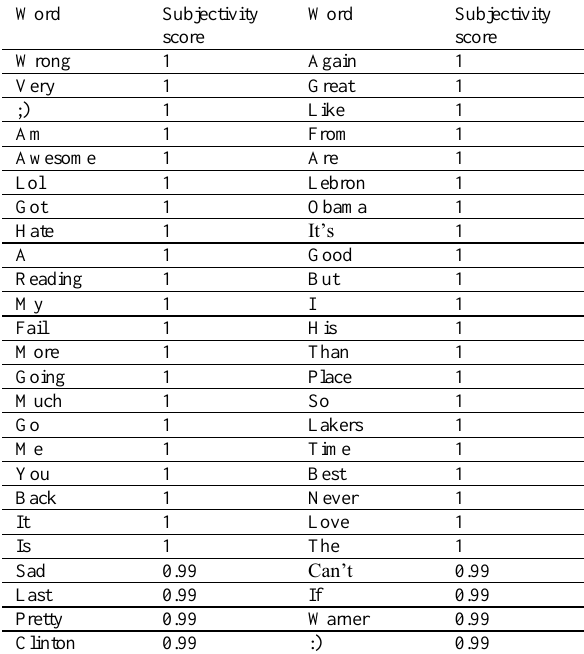
Table 4. The most subjective words based on subjectivity score.